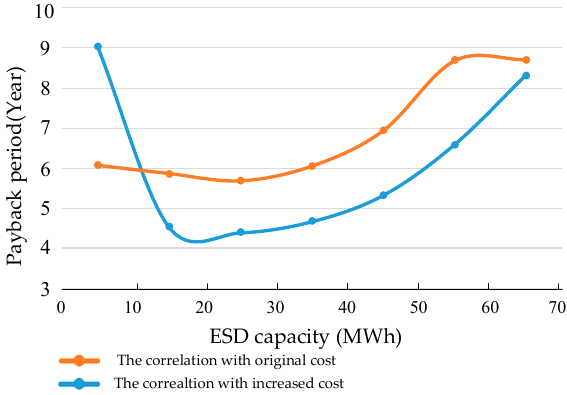
Figure 13. Impact of cost increasing on the correlation between payback period and ESD capacity.